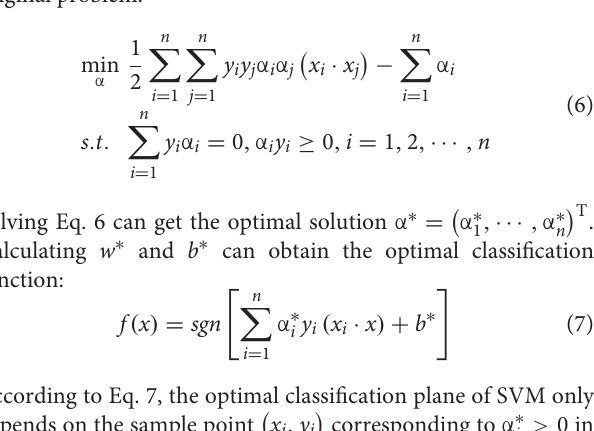
FIGURE 2 | Schematic diagram of the linearly separable optimal classification